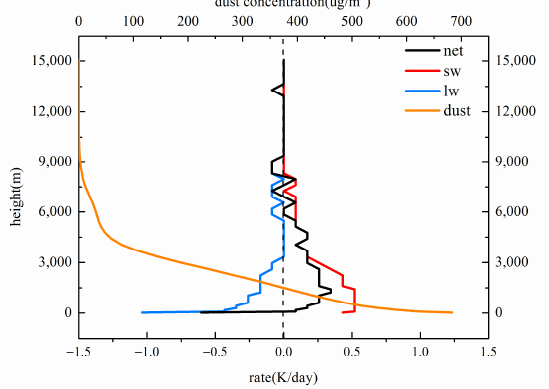
Figure 12. Vertical profiles of dust concentration (orange solid line) and dust-induced changes in the SW (red line), LW (black line), and net (SW + LW, blue line) radiative heating profiles within the TB averaged throughout the selected dust storm.